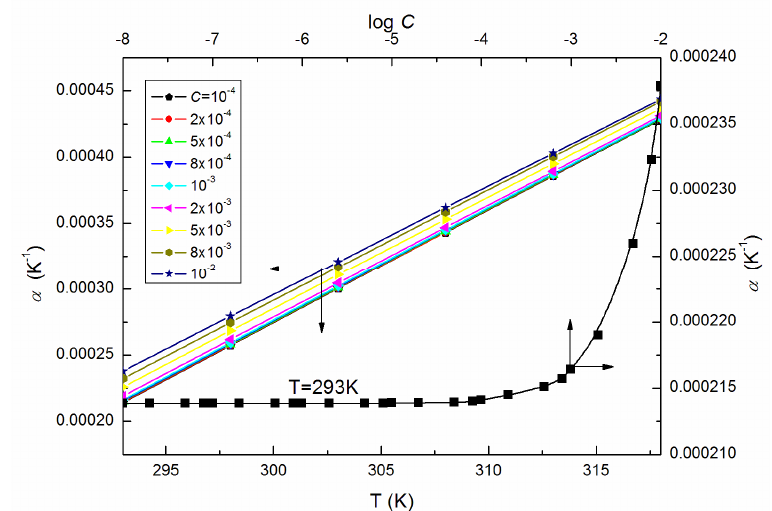
Figure 11. A plot of the volume expansivity α of the aqueous solutions of ELP at C from 10 − 4 to 10 − 2 M vs. the temperature, T, as well as the values of α of the aqueous solutions of ELP at T = 293 K vs. log C .